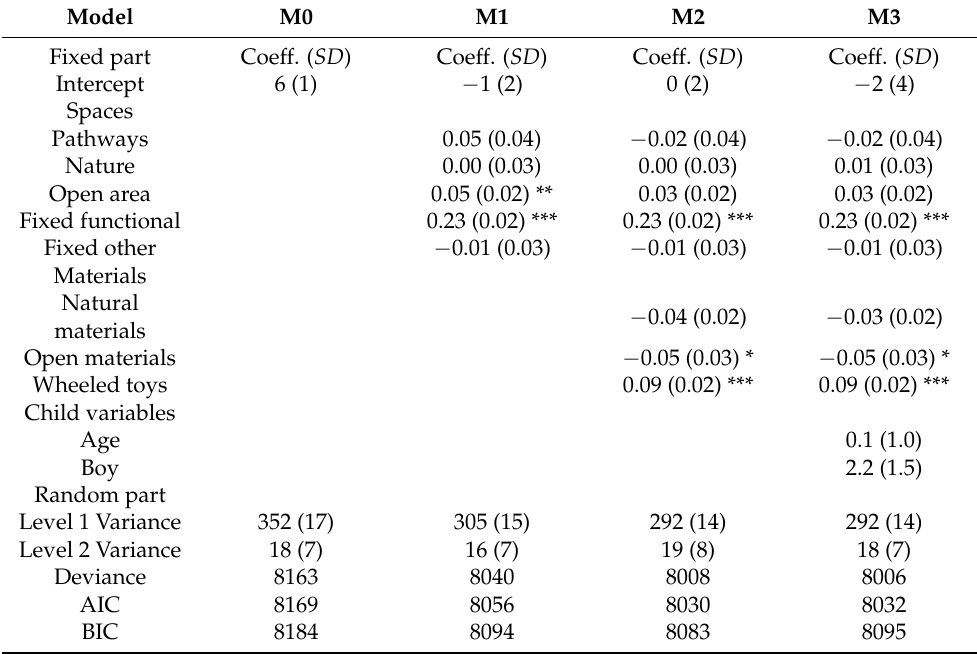
Table 3. Regression models for play with high speed ( n = 935